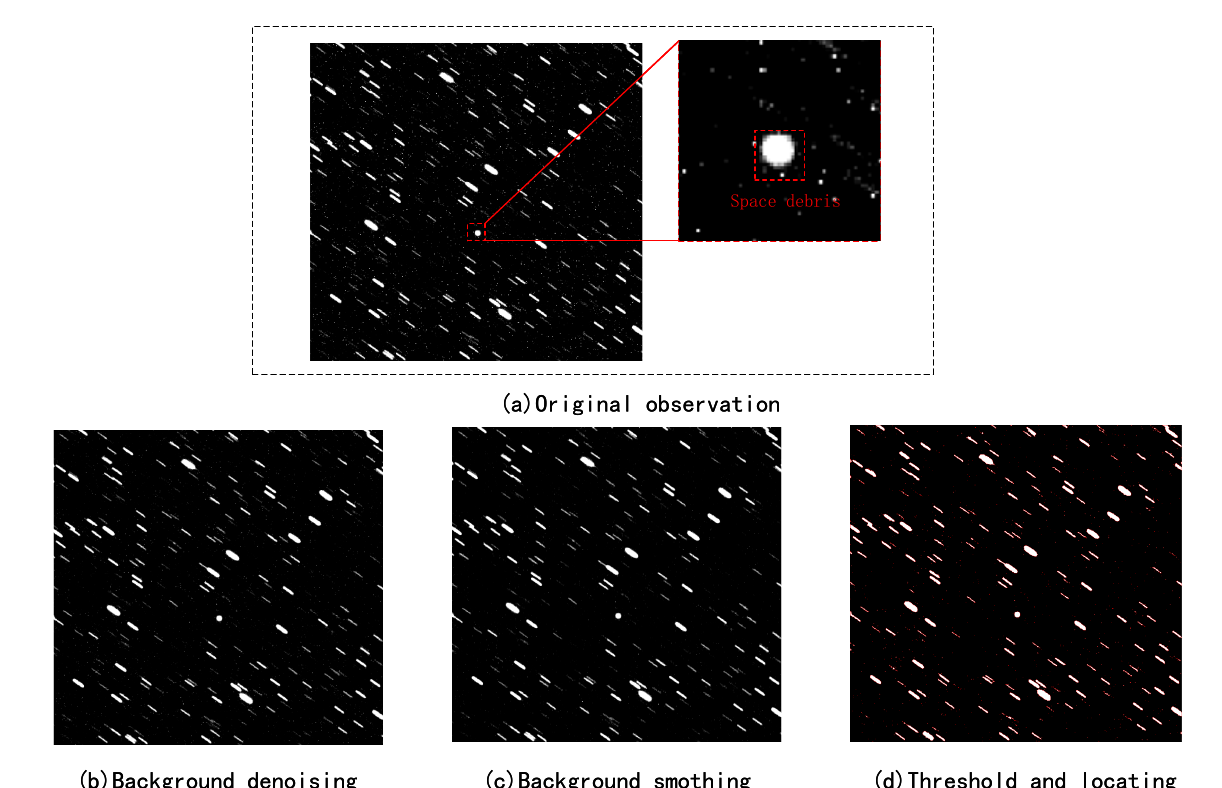
Figure 2. The image is a subsection of real observation of a ground-based telescope. ( a ) The original observation image. Space debris is point-like and stars are stripe-like. ( b )The result of background denoising. ( c ) The result of background smoothing. ( d ) The result of threshold and